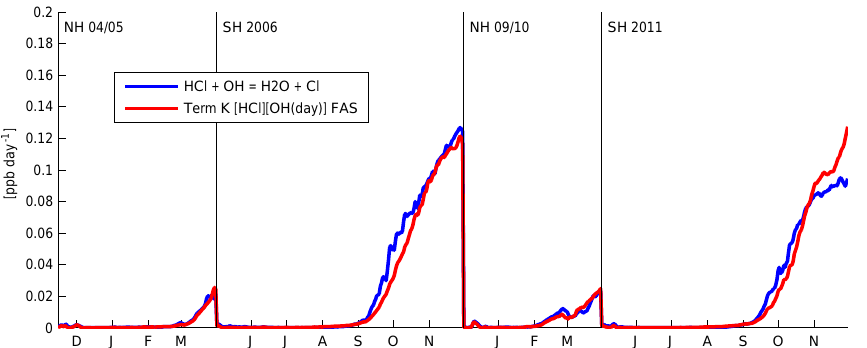
Figure 9. Fit of term K for the Arctic winter 2004/2005, the Antarctic winter 2006, the Arctic winter 2009/2010 and the Antarctic winter 2011 at 54hPa. Vortex-averaged reaction rate modeled by ATLAS for the reaction HCl + OH (blue) and the fitted term K (red). Tick marks on the horizontal axis show start of months.